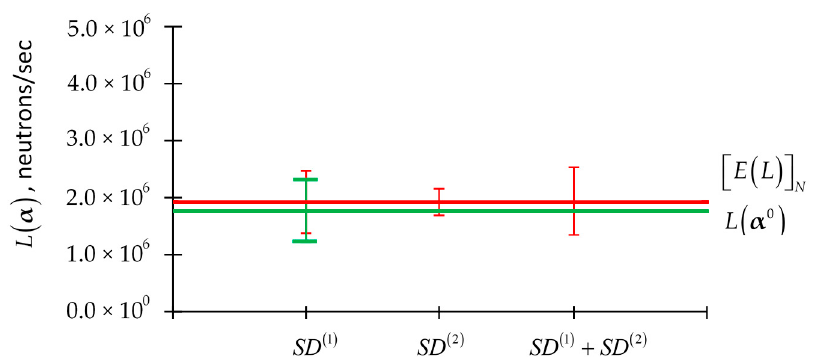
Figure 12. Comparison of SD α (in green), due to 5% standard deviations of the uncorrelated total microscopic cross sections.